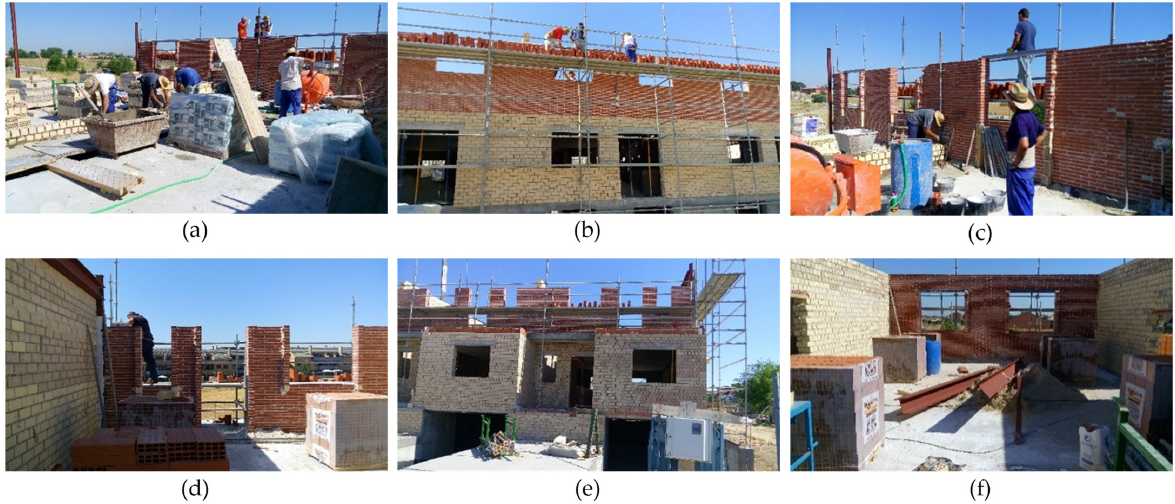
Figure 5. Different moments of the work unit in the case study: construction of an exposed brick façade: ( a ) Site Organisation; ( b ) Work on Scaffolding; ( c ) Personal Protection; ( d – f ) Fall Risks.